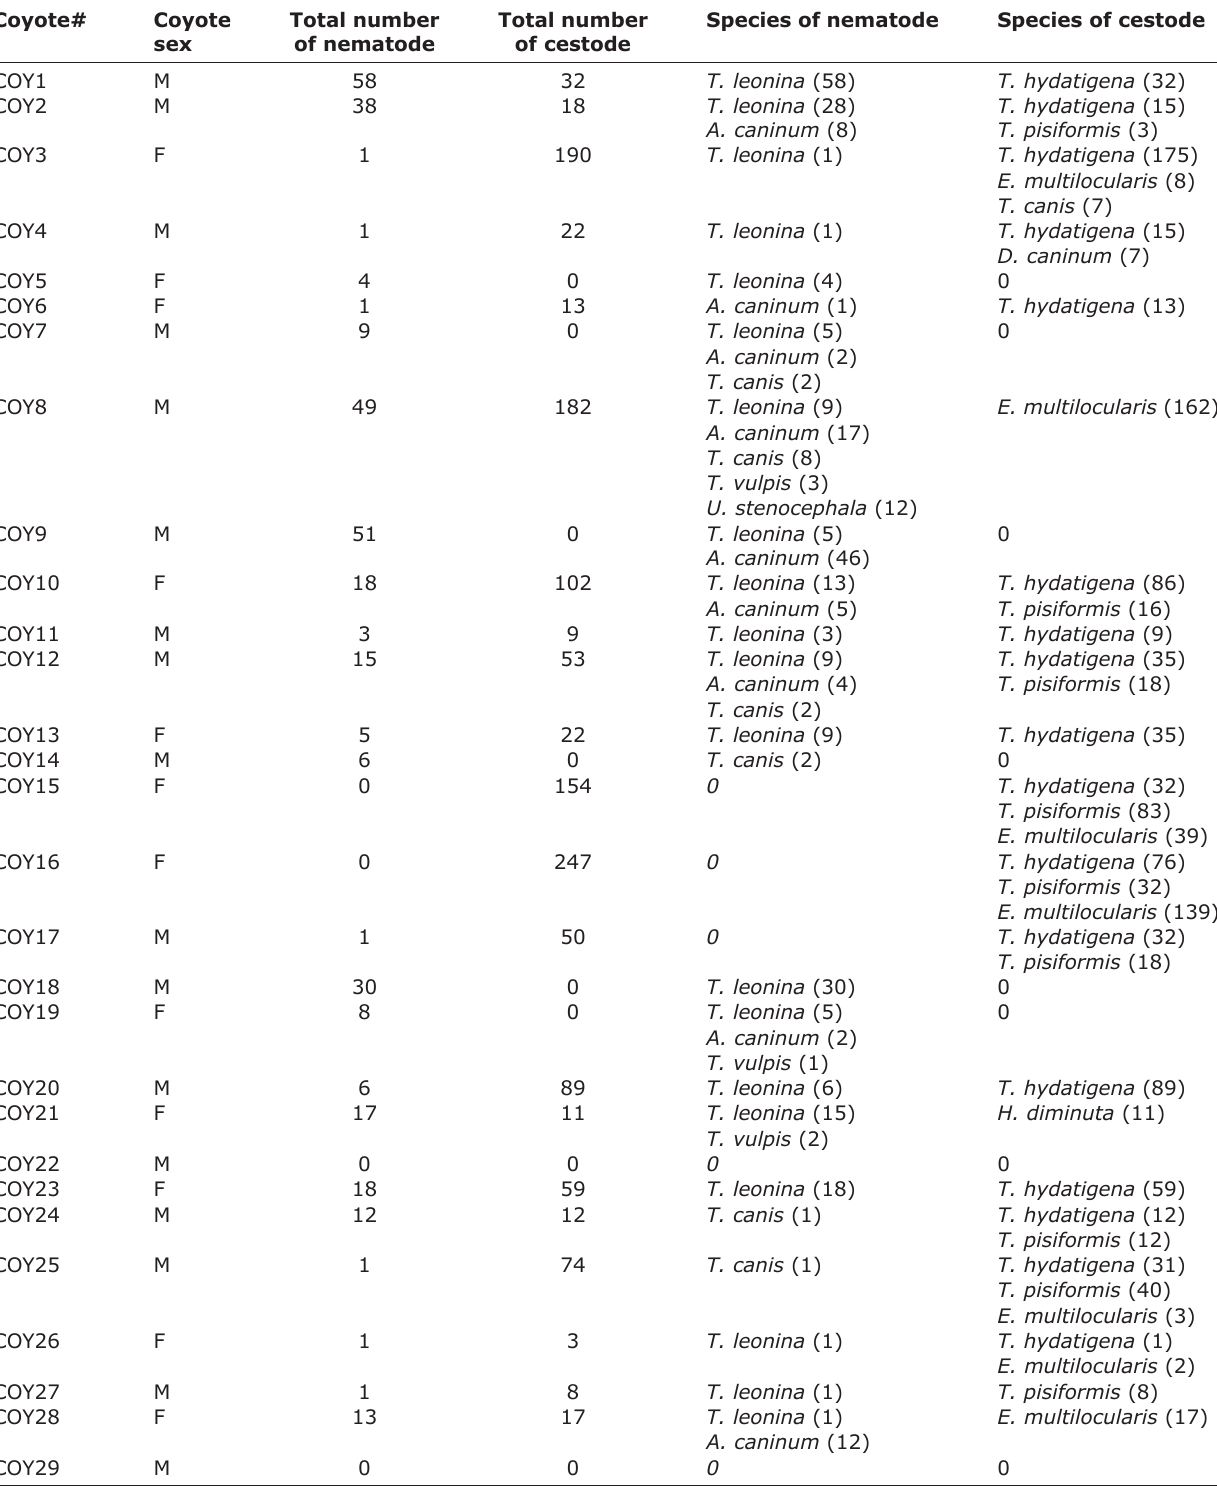
The number in the parenthesis indicates the number of individual parasites recovered from that animal. T. leonina=Toxascaris leonina, A. caninum=Ancylostoma caninum, T. canis=Toxocara canis, T. vulpis=Trichuris vulpis, U. stenocephala=Uncinaria stenocephala, T. hydatigena=Taenia hydatigena, T. pisiformis=Taenia pisiformis, E. multilocularis=Echinococcus multilocularis, D. caninum=Dipylidium caninum, H. diminuta=Hymenolepis